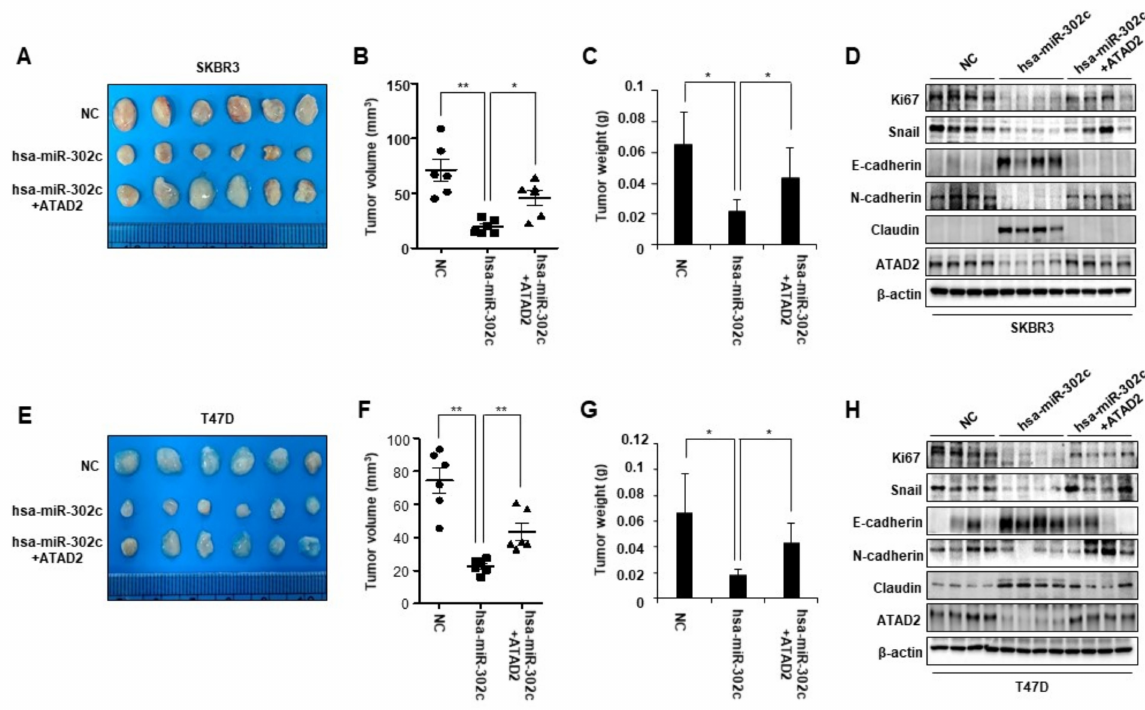
Figure 6. miR-302c suppresses tumor growth by targeting ATAD2. Mock, miR-302, or miR- 302/ATAD2 expressing SKBR3 or T47D cells were subcutaneously injected into nude mice. ( A , E ) Representative photograph of tumors. Tumor volume ( B , F ) and tumor weight ( C , G ) were calculated as described in Materials and Methods. ( D , H ) The levels of indicated proteins in tumor tissue samples were analyzed via Western blot. Statistical analyses were performed using paired two-tailed Student’s t -test. * p < 0.05, ** p <